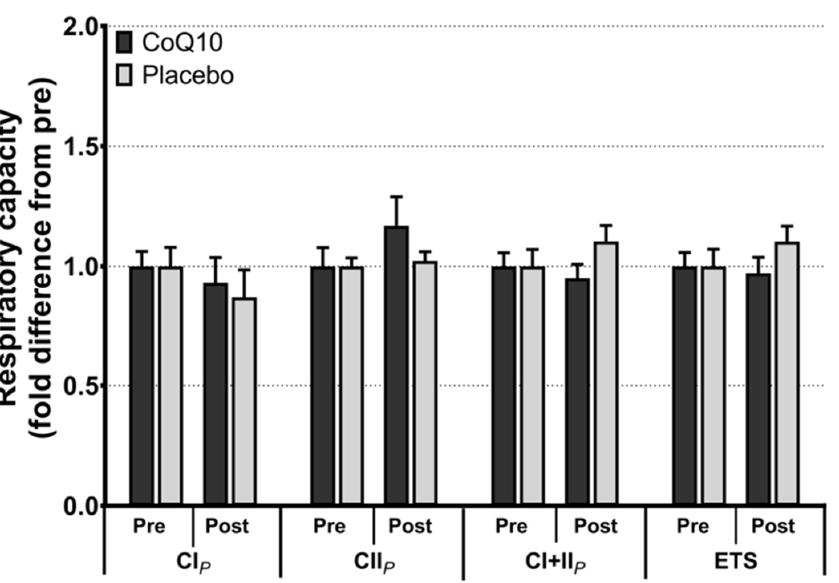
Figure 3. Maximal mitochondrial respiratory capacity with electron flow through complex I (CI P ), complex II (CII P ), complex I + II (CI + II P ), and maximal uncoupled respiration (electron transport system capacity, ETS). Data is expressed as fold difference from pre (mean ± SEM, n: CoQ10: 15, placebo: 14). Error bars on “Pre” bars are SEM of fold difference from the mean.